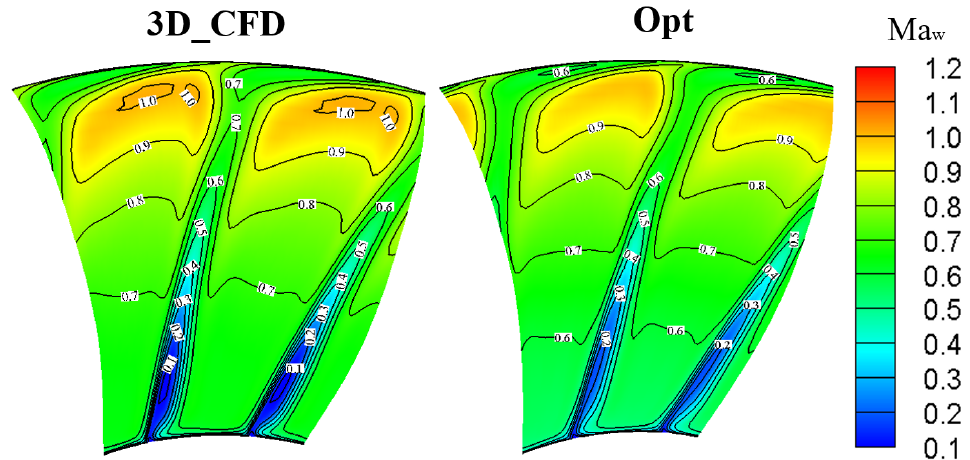
Figure 18. The distribution of relative Mach number under the choking condition.